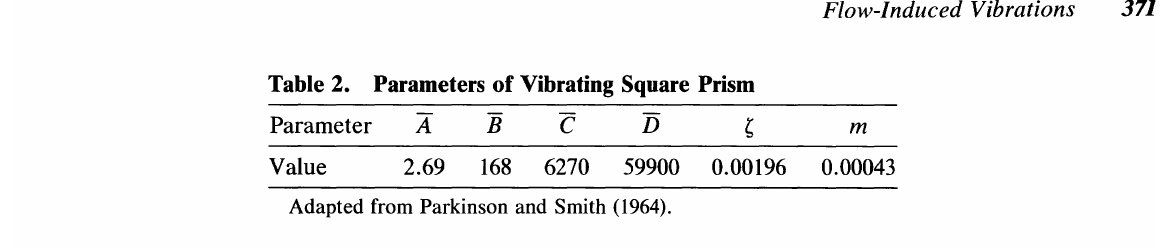
Table 2. Parameters of Vibrating Square Prism Parameter If Adapted from Parkinson and Smith (1964).